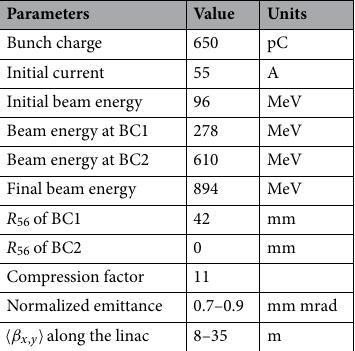
Table 1. Table of parameters used for the simulations of FERMI linac.